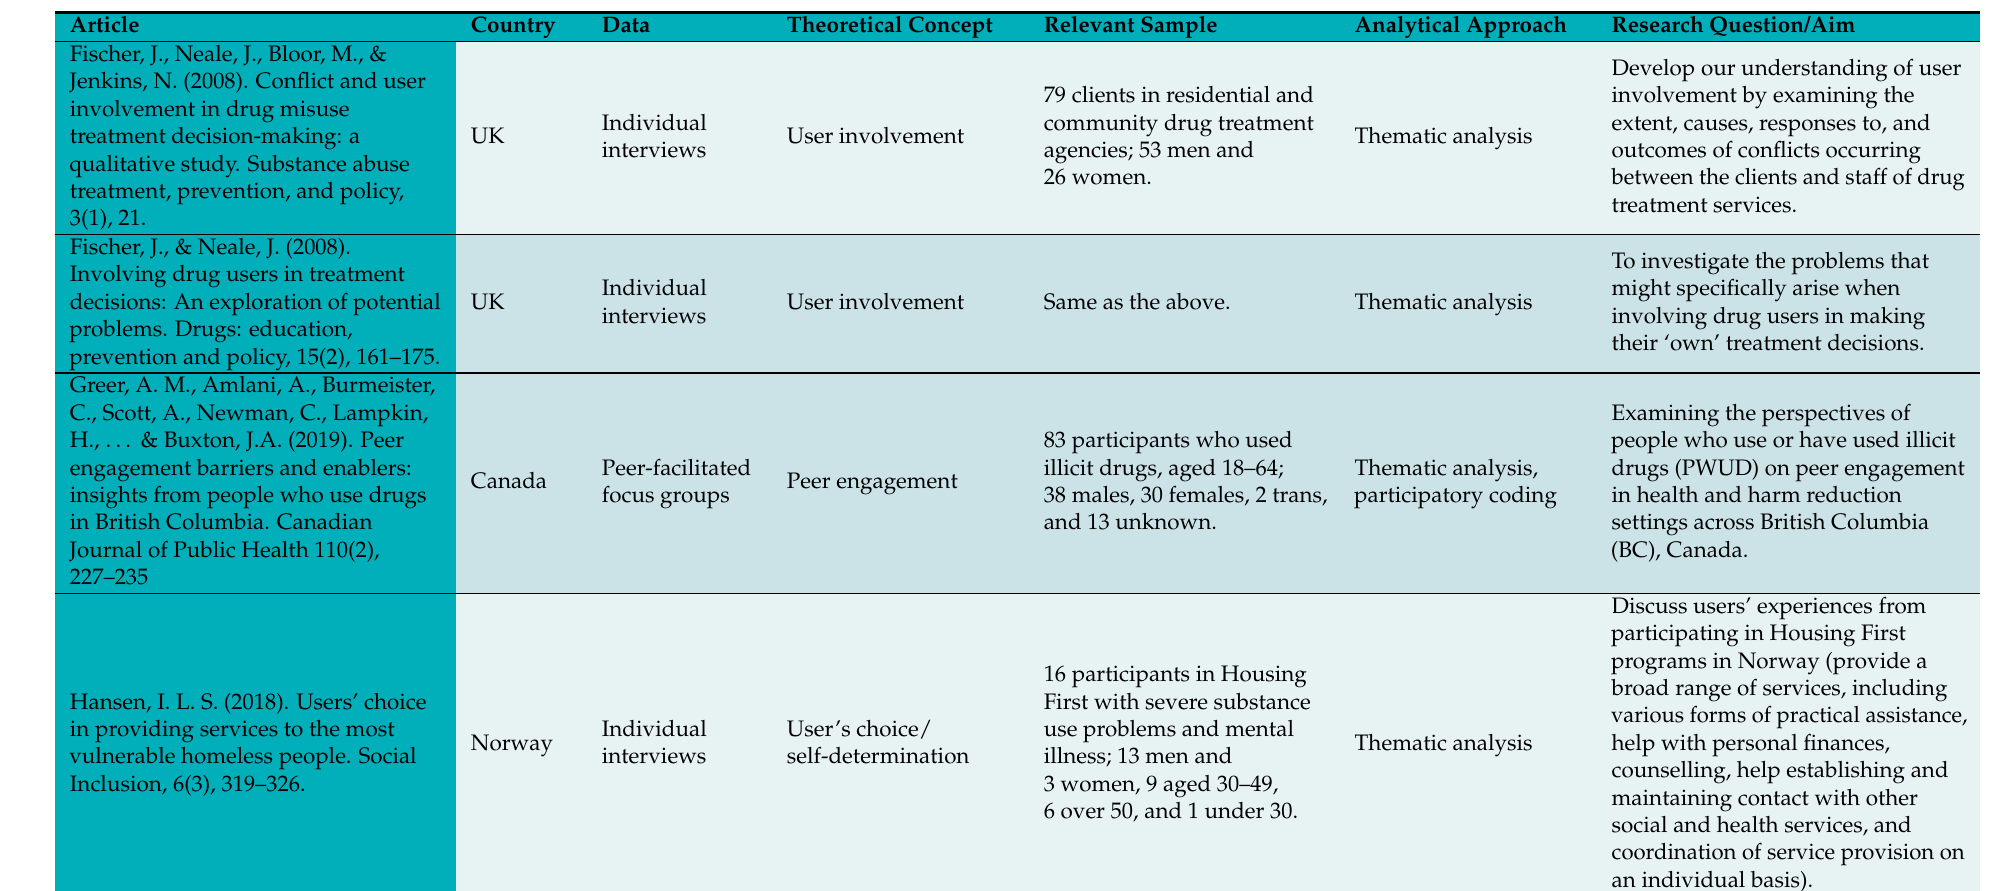
Table 2. Presentation of included contributions and key